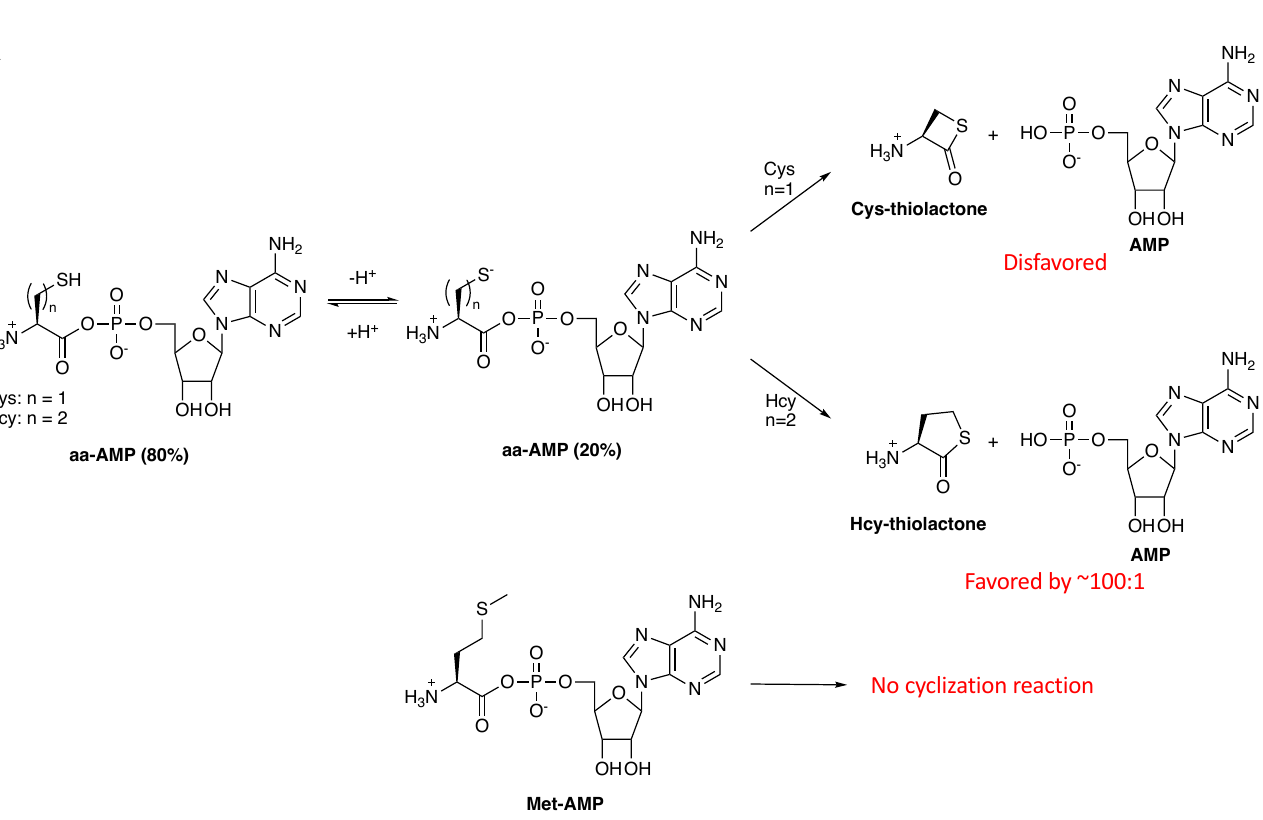
Figure 5. Cys-AMP and Hcy-AMP, but not Met-AMP, can degrade via cyclization. ( A ). When deprotonated, both Cys-AMP and Hcy-AMP can cyclize to their respective thiolactones. The five-membered ring formed by homocysteine is favored over the four-membered ring formed by cysteine [48]. ( B ) The methionine side chain is not nucleophilic under physiological conditions and so a similar cyclization reaction will not